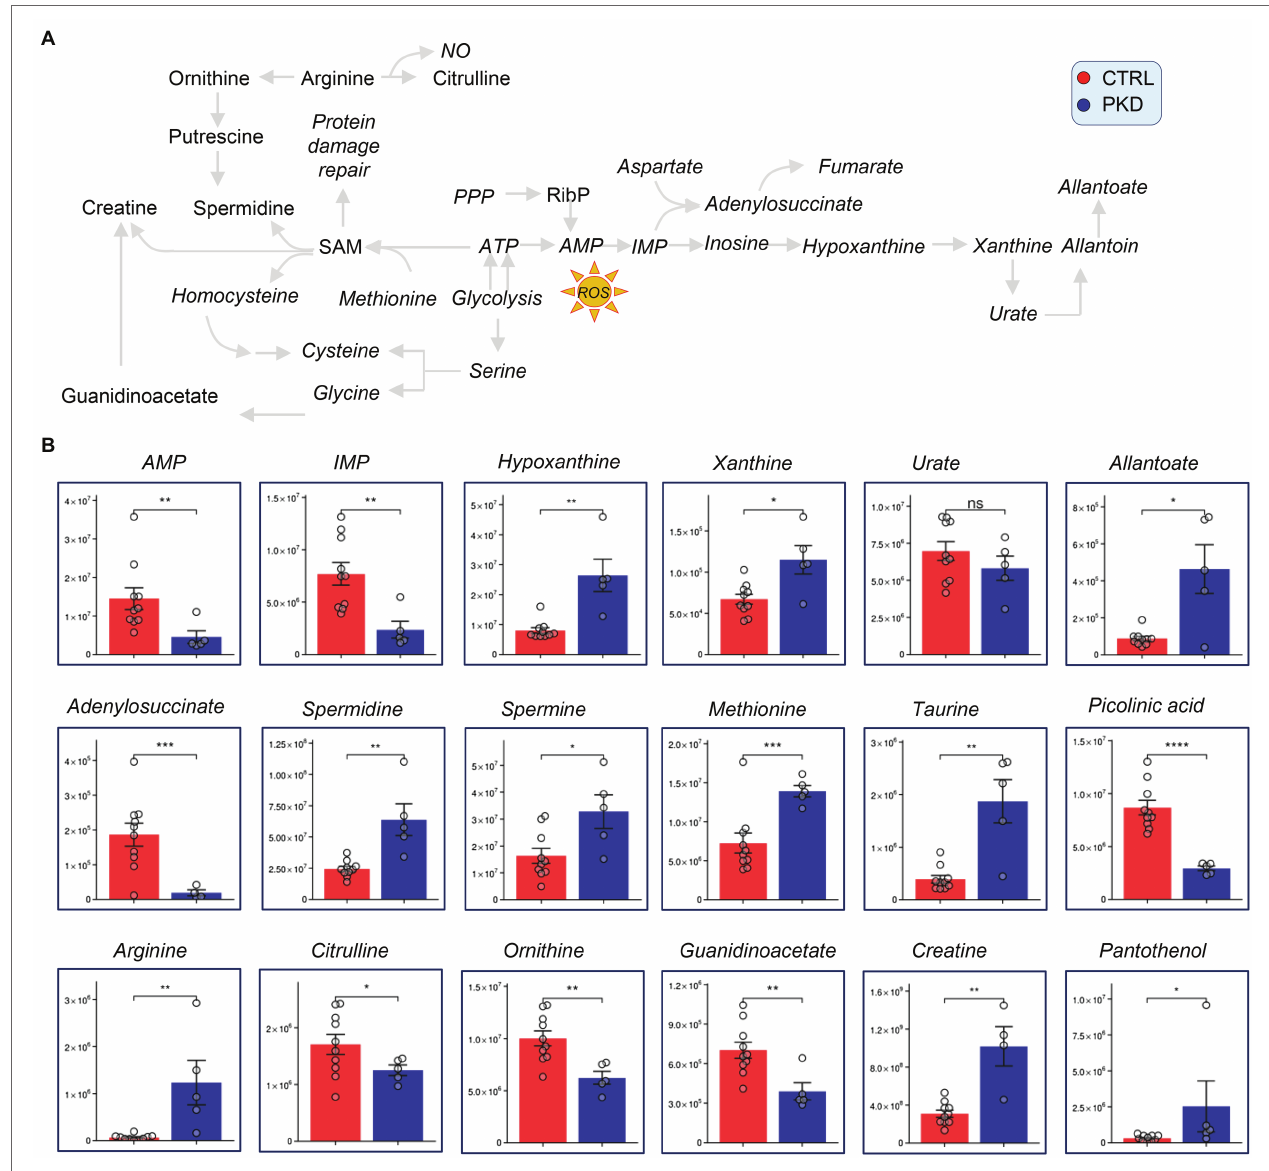
FIGURE 4 | Pyruvate kinase deficiency patients show altered levels of polyamine, purine, methionine, and arginine metabolism. Overview of methionine, arginine, and purine metabolism, and downstream metabolites (A) . (B) Y-axes represent peak area (arbitrary units). Asterisks indicate significant results, error bars represent ±SEM (unpaired t -test, two-tailed distribution, * p < 0.05, ** p < 0.01, *** p < 0.001, and **** p <